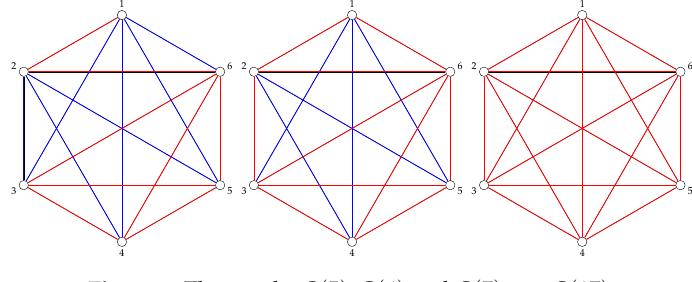
Figure 4. The graphs G ( 5 ) , G ( 6 ) and G ( 7 ) , . . . , G ( 17 )